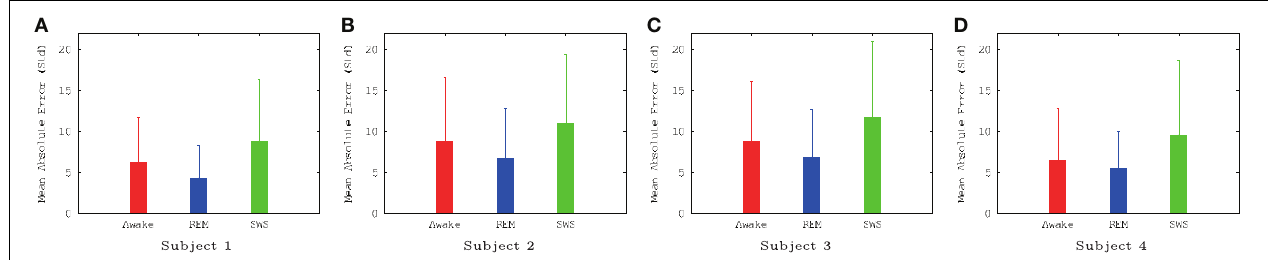
FIGURE 3 | Summary of EEG IPI prediction error results (mean and standard deviation). Mean and standard deviation of IPI prediction error are shown for all four subjects, for all three conditions (awake, REM, and SWS). The unit for the y -axis was 10 ms. For all subjects, awake and REM conditions resulted in lower IPI prediction error than SWS, showing that predictive